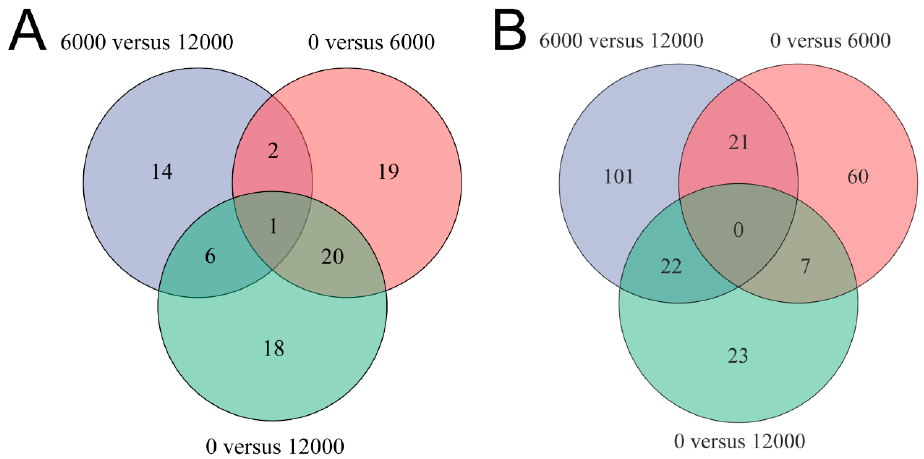
Figure 3. Venn diagram analysis among three compared groups: ( A ) differential metabolites; ( B ) differentially expressed genes.